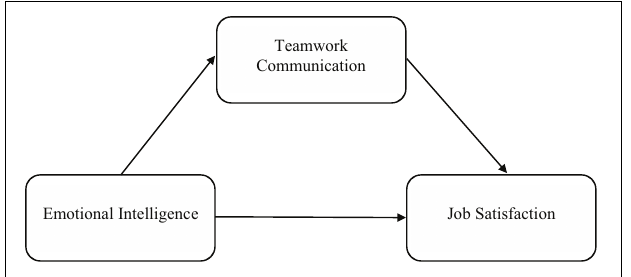
FIGURE 1 | Proposed model of the role of teamwork communication in explaining the emotional intelligence–job satisfaction